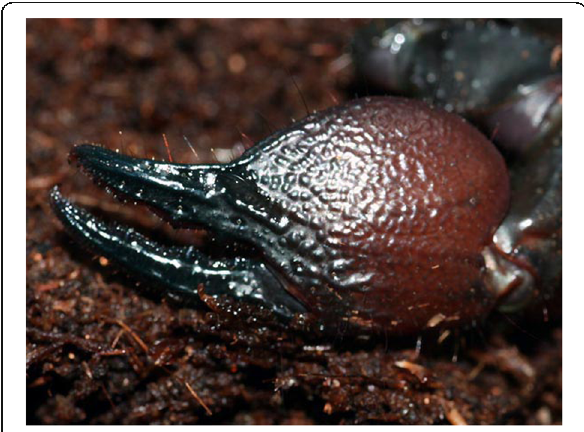
Fig. 4 The very strong pedipalp-chela of a Pandinus imperator from Africa (copyright by E. Ythier, reproduced with